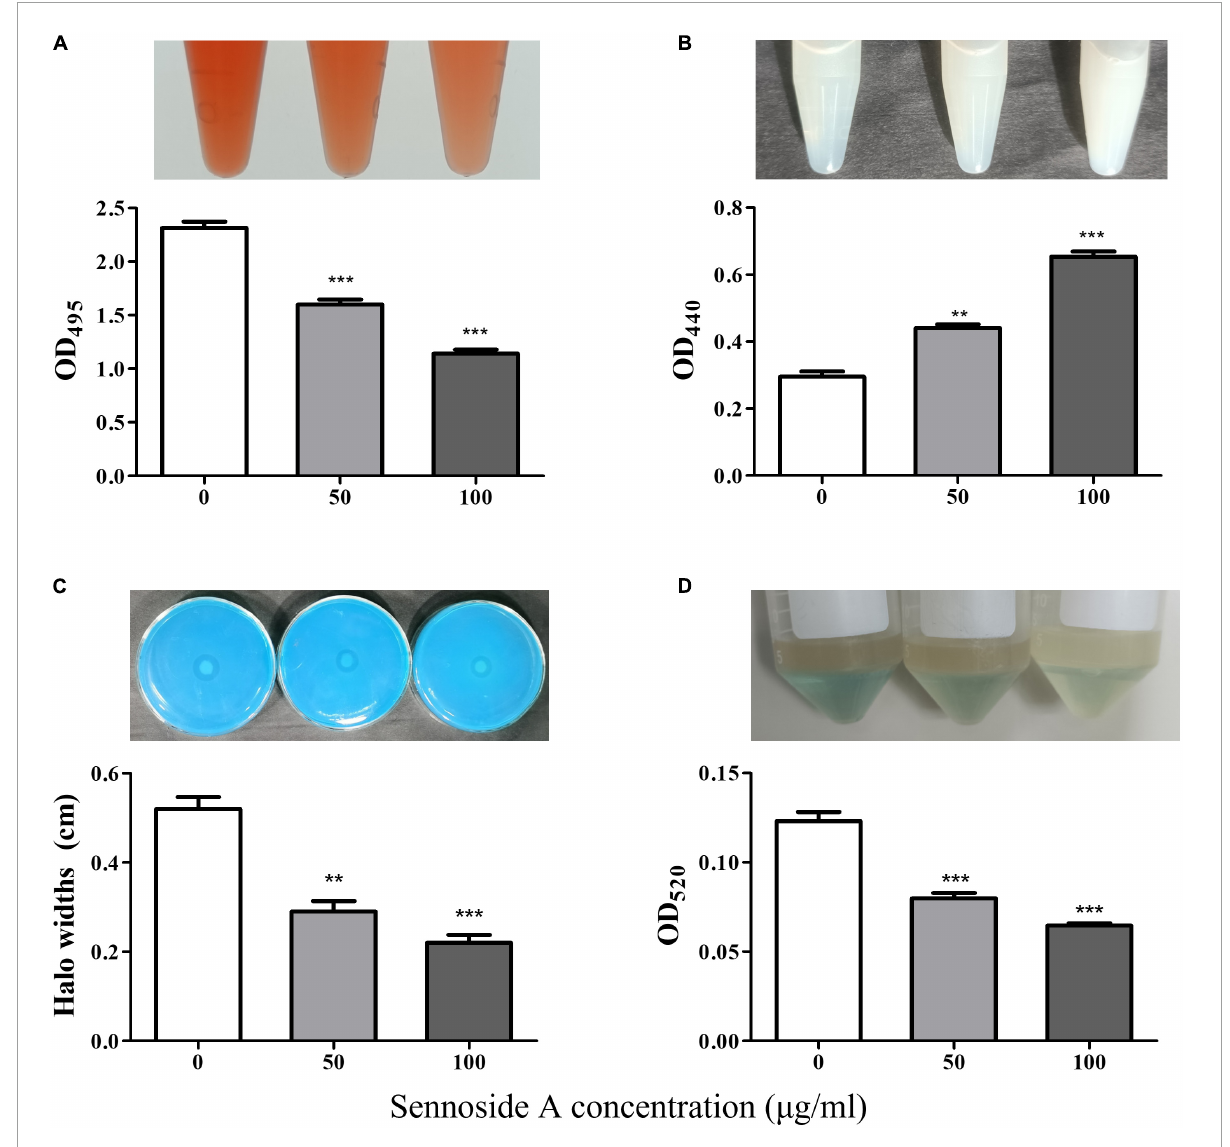
FIGURE4 Inhibition effect of SA on the production of virulence factors in PAO1. (A) Protease; (B) elastase; (C) rhamnolipid; and (D) pyocyanin. All data were expressed as mean ± SD values with three independent experiments performed in triplicate. ** p < 0.01; *** p <